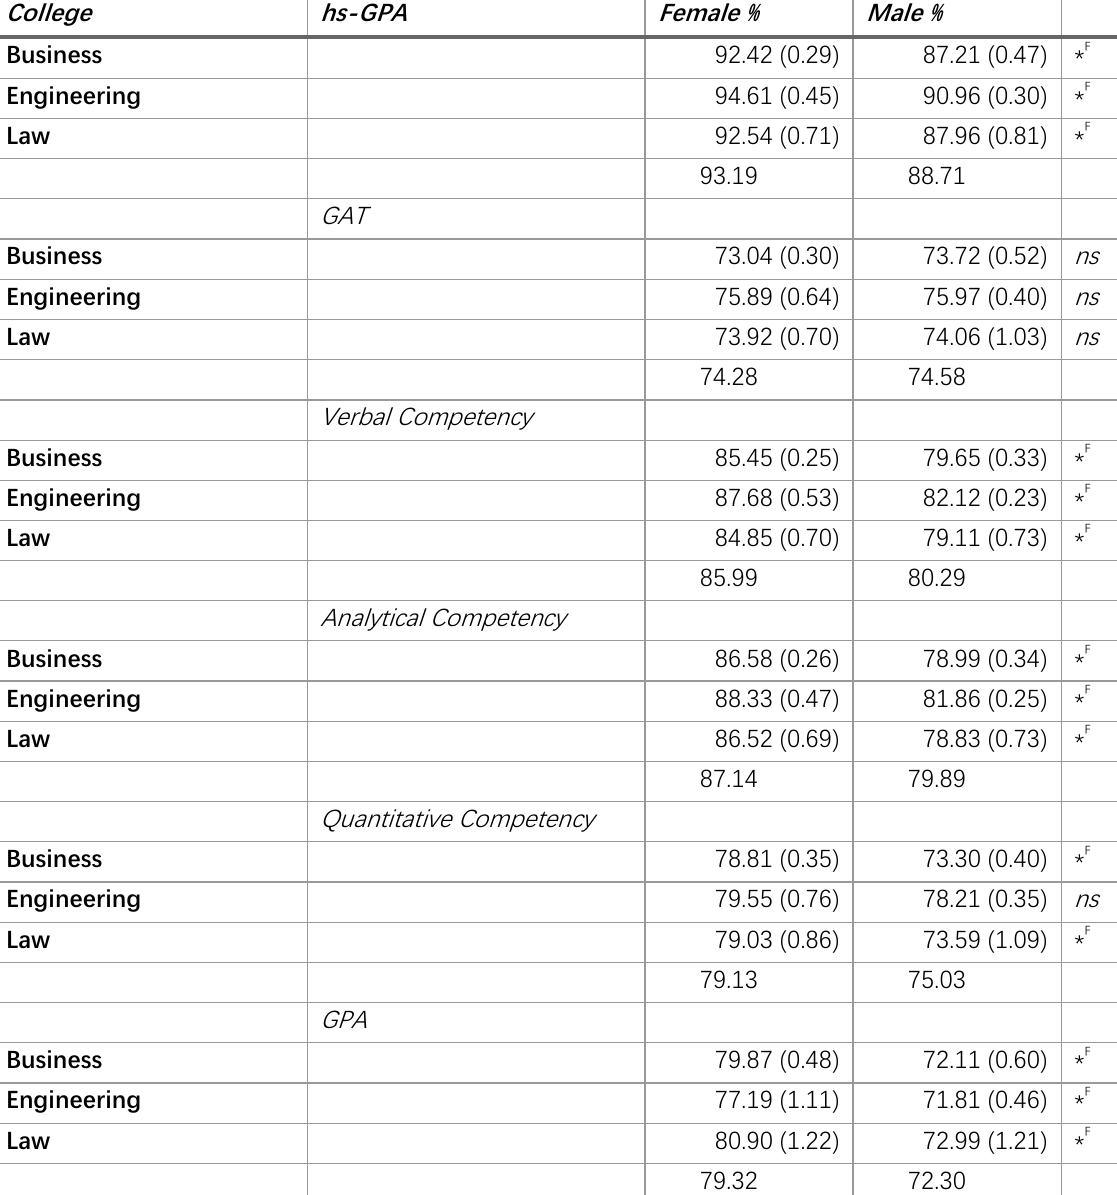
Table 2: Descriptive Statistics: Mean and Standard Error of the Mean (in Parentheses) as a Function of Gender and College